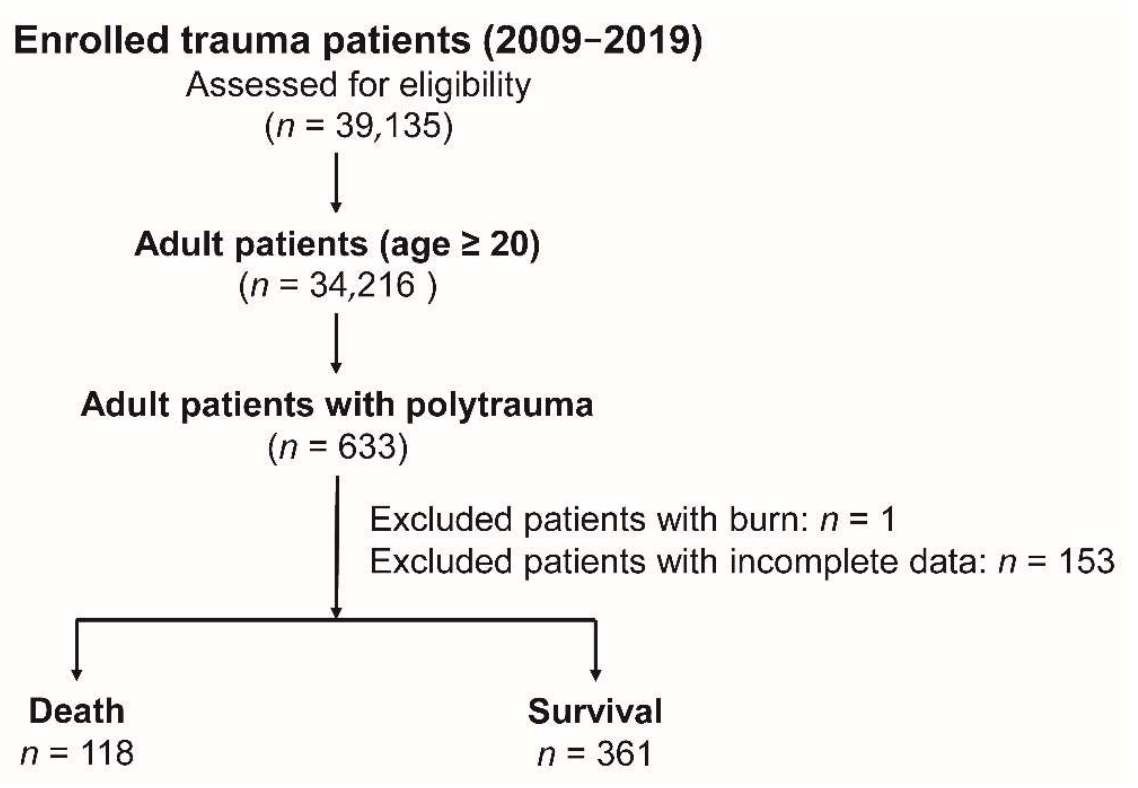
Figure 1. Flowchart of the process for enrolling adult patients with polytrauma.